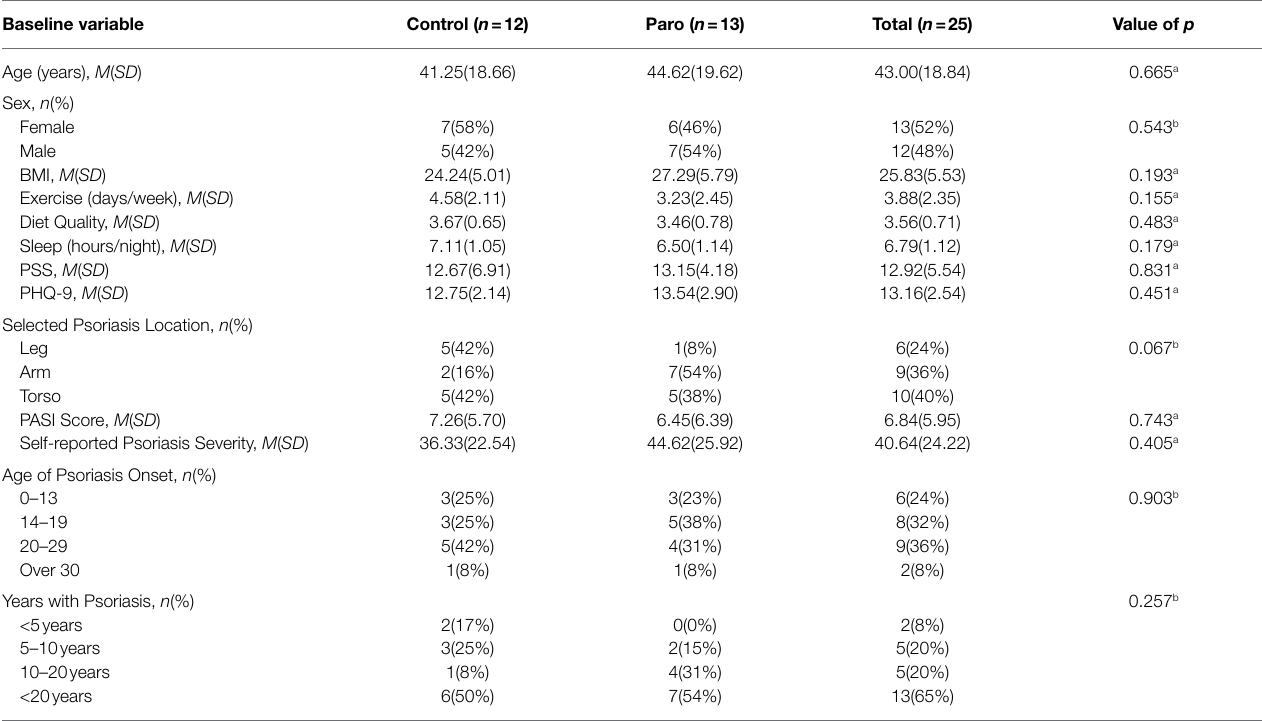
TABLE 1 | Summary of demographic and baseline characteristics across